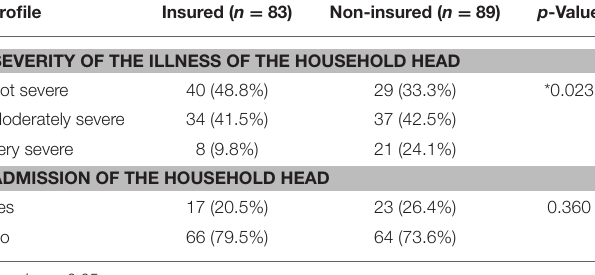
TABLE 8 | Geographical access to BCH among the respondents that visited BCH for self.